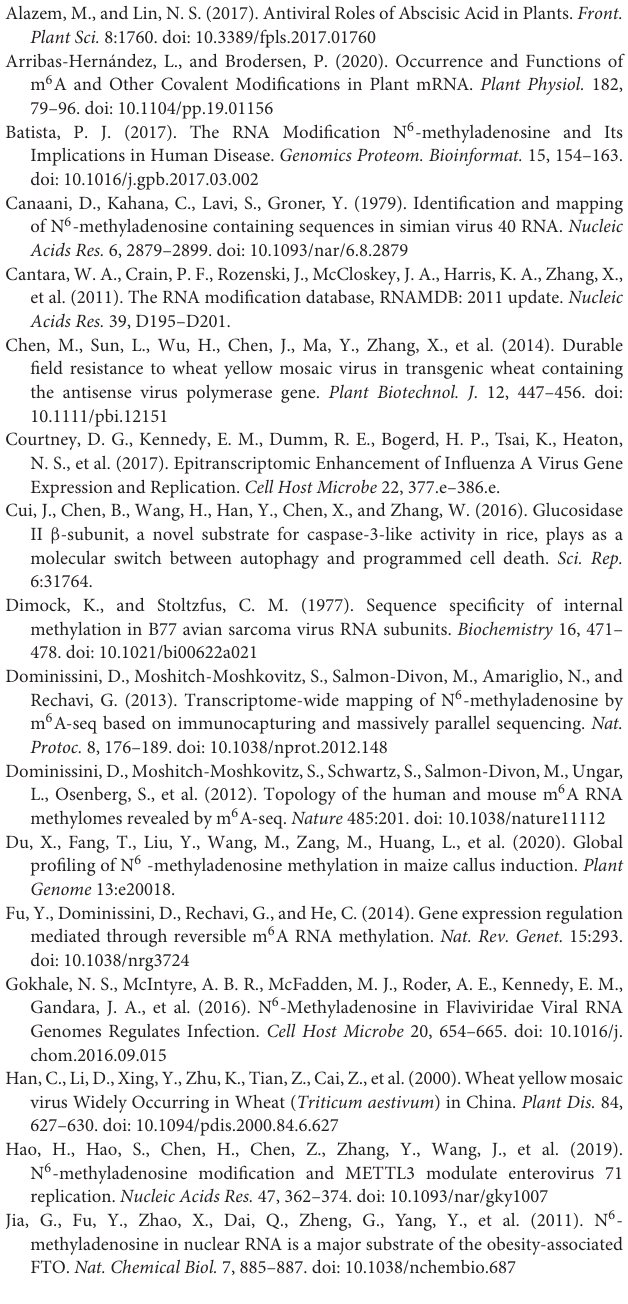
Supplementary Figure 1 | RT-qPCR assays of WYMV CP in WRV and WSV samples. Supplementary Figure 2 | Unique m 6 A peak distribution in the indicated regions in WRV and WSV samples. Supplementary Figure 3 | The phenotype of two variety plants infected with WYMV. Supplementary Figure 4 | RT-qPCR assay of TaFIP37-1 and TaALKBH29B.